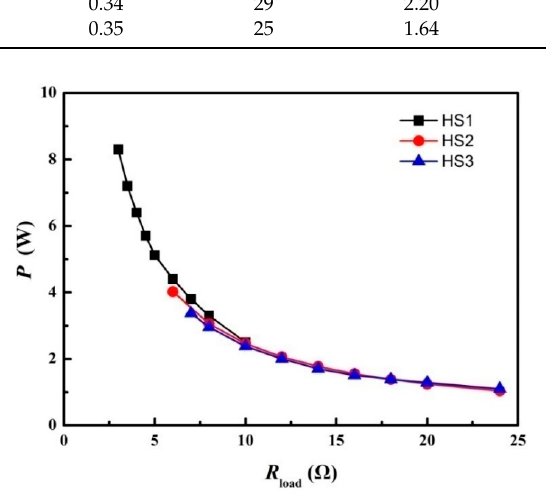
Figure 7. The power load feature of the STEG as different heat sinks were used.